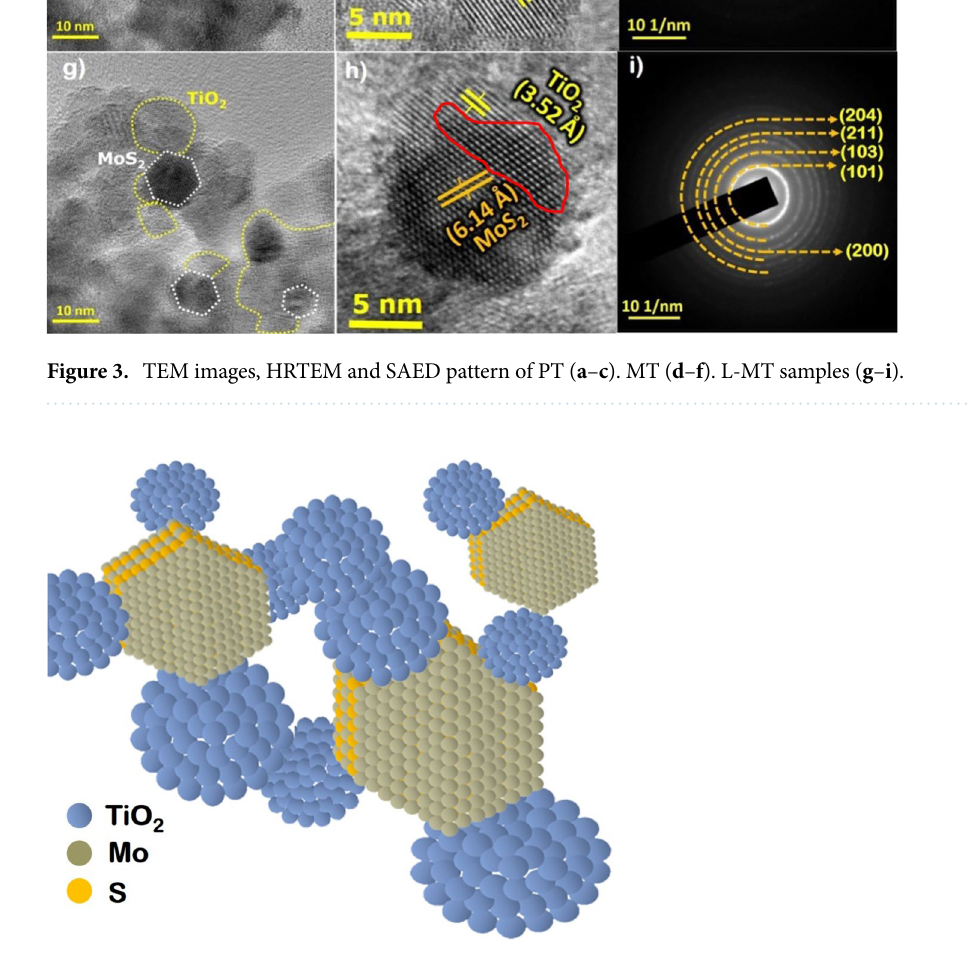
Figure 4. Schematic representation of hexagonal layered MoS 2 attached on spherical shaped TiO 2